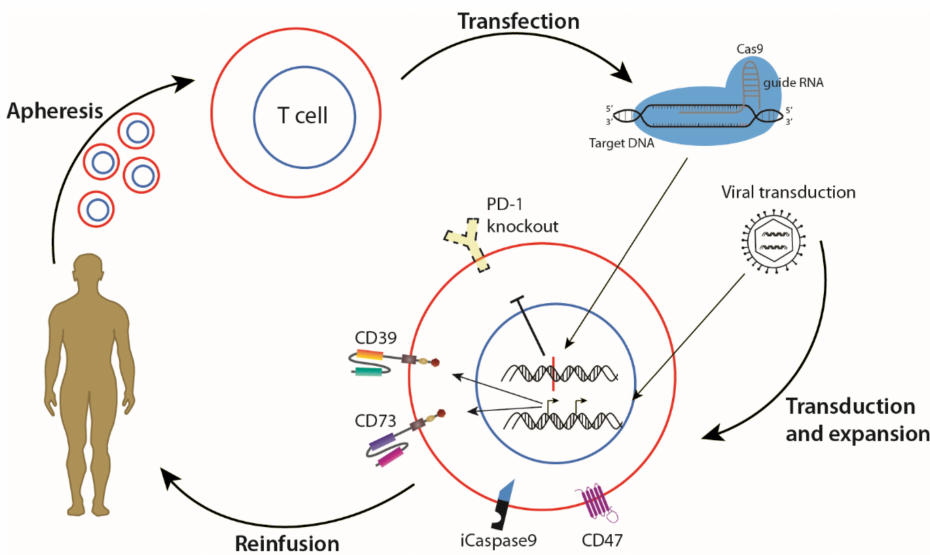
Figure 4. Combination CAR T cell therapy with gene editing to treat GBM. T cells are isolated from the blood of a cancer patient. CRISPR/Cas9 gene editing technology can then be used to knock out inhibitory receptor PD-1, and viral transduction induces expression of chimeric antigen receptors (CARs) targeting tumour-associated antigens CD73 and CD39. To avoid serious adverse events, inducible Caspase 9 (iCaspase9) can be activated to swiftly eliminate the adoptively transferred cells. The altered T cells can then be expanded and re-introduced to the cancer patient. Image adapted with permission from [111] from AAAS. gRNA, guide RNA; PD-1, programmed cell death protein 1; CD39, cluster of differentiation (CD) 39 (Ectonucleoside triphosphate diphosphohydrolase-1); CD73, (5 (cid:48) -nucleotidase); CD47, (integrin-associated